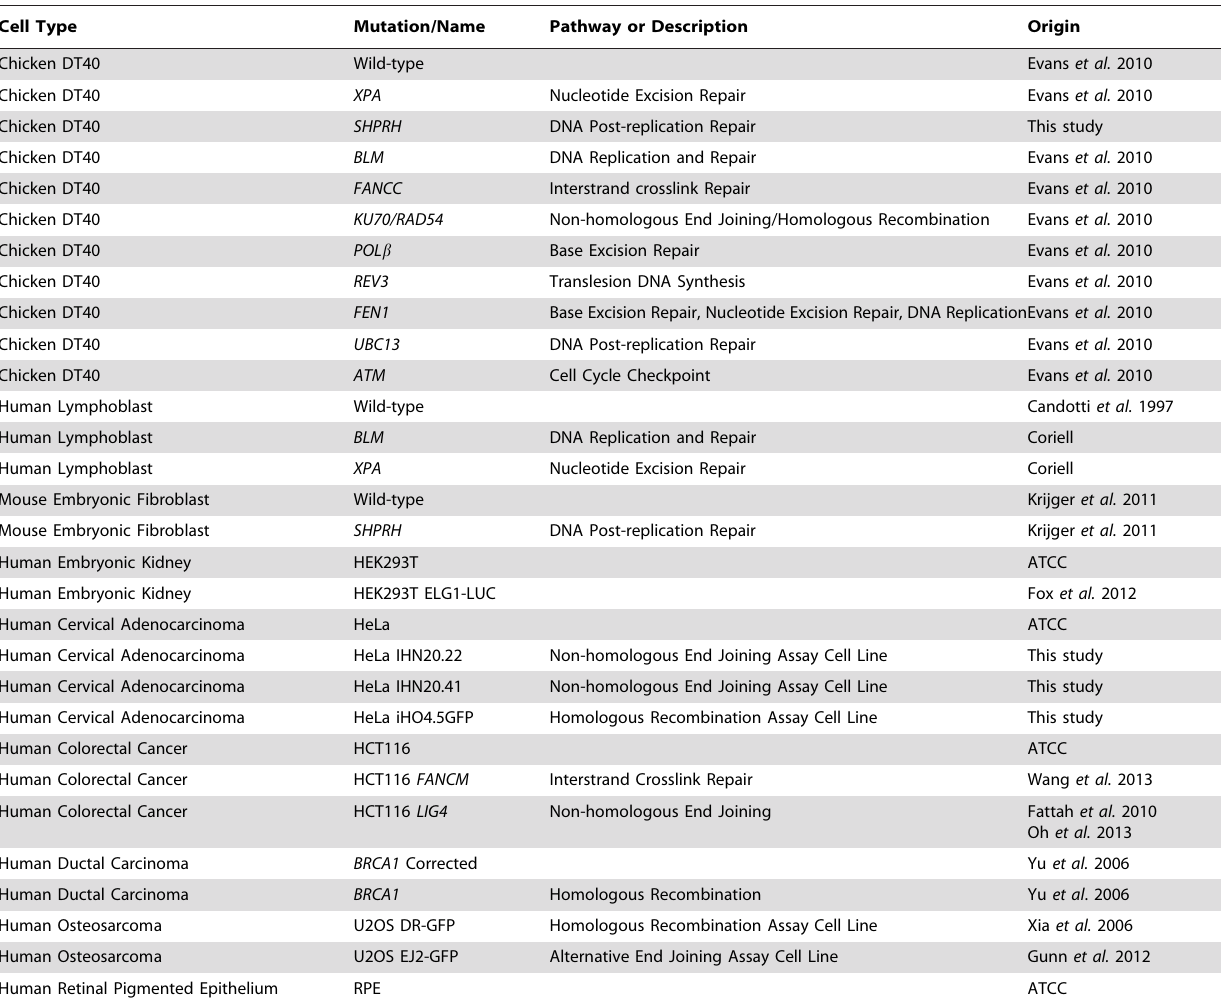
Table 1. Cell lines used in this study.